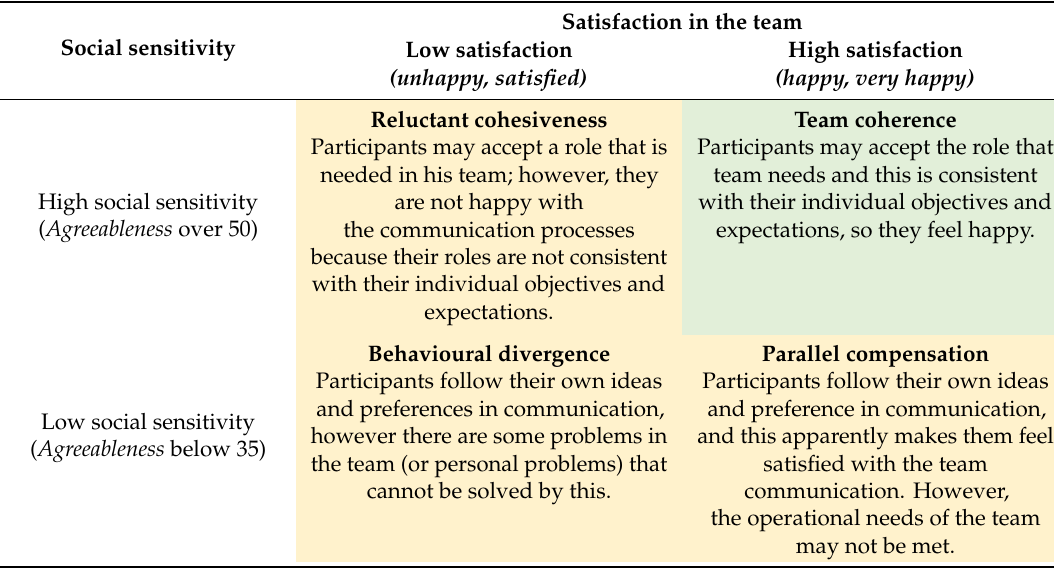
Table 5. Social sensitivity and satisfaction in the project